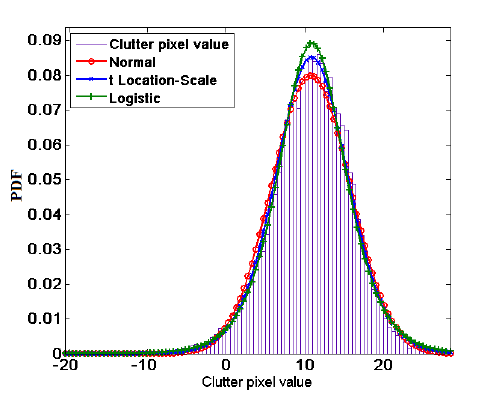
Figure 15. Clutter Gaussian trend with pixel values in dB. Logistic and t-location scale distribution for